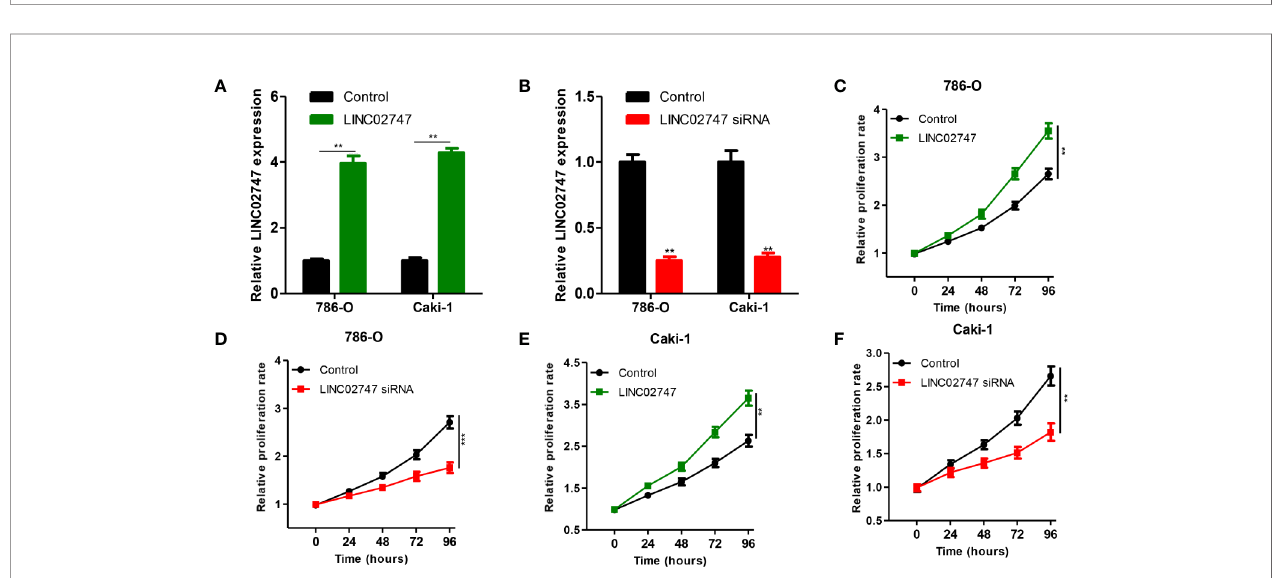
FIGURE 3 | Veri fi cation ef fi ciency of overexpressed LINC02747 (A) or downregulated LINC02747 (B) in 786-O and Caki-1 cell lines by qRT-PCR. After alteration of LINC02747 expression, the proliferation of 786-O (C, D) and Caki-1 (E, F) cells was changed. (*** P < 0.001, ** P < 0.01, * P < 0.05).